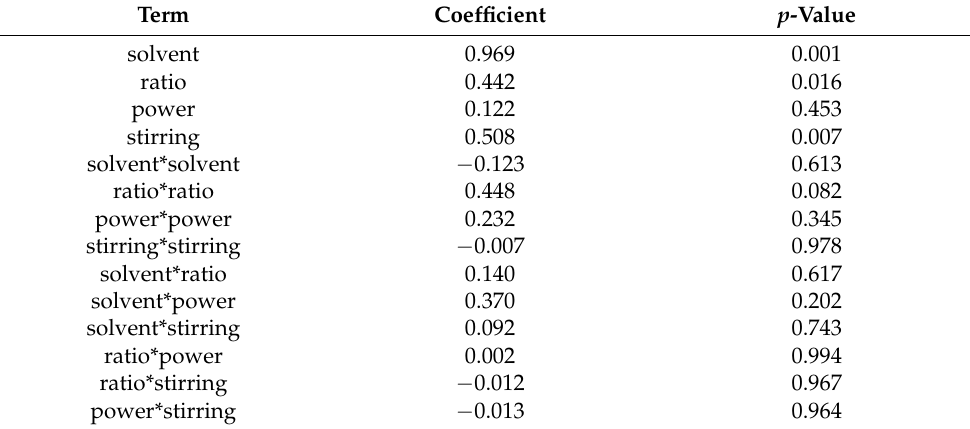
Table 2. Estimated regression coefficients and p -values for variables in the standardized